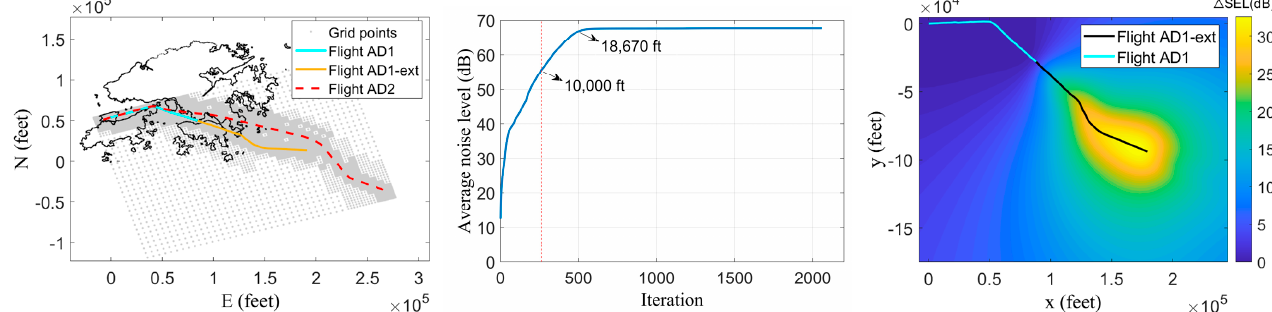
Figure 24. A330 aircraft departing from HKIA. Impact of the flightpath extension, as revealed by comparing flight AD1-ext to AD1. Left: respective routes and ground observers. Center: history of the ground noise impact by the AD1-ext flight, plotted as an averaged (over all observers) and cumulative (over all flight segments) measure. Right: Differences between the ground noise levels recorded for AD1-ext and AD1 flights.